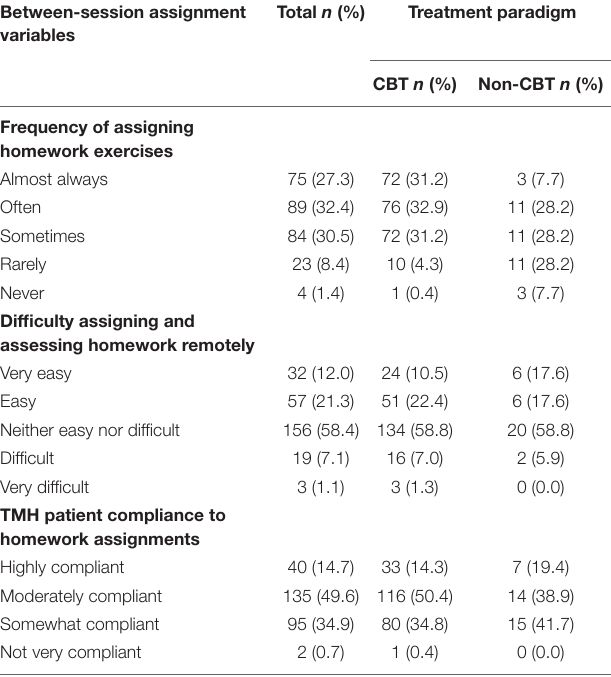
TABLE 4 | Process of assigning homework via